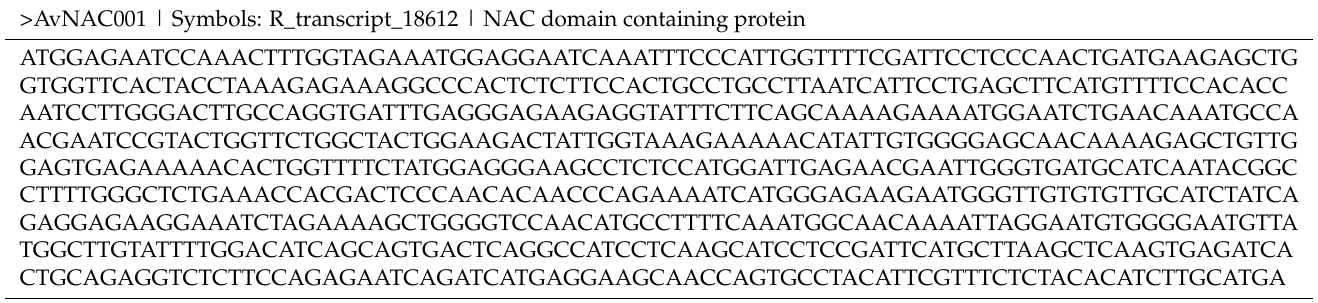
Table A1. The nucleotide and amino acid sequences of the AvNAC